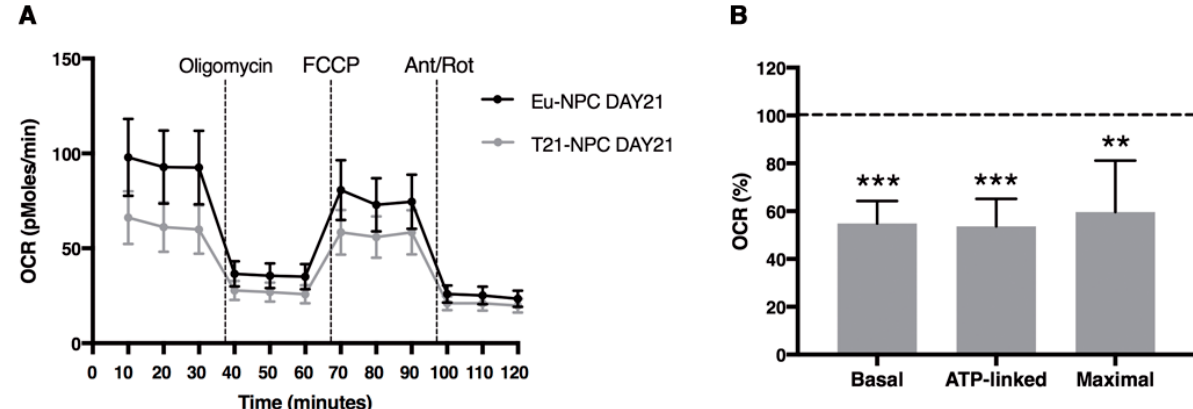
Figure 12. Mitochondrial respiratory function in euploid and trisomic NPCs at day 21 of culture in differentiation medium. ( A ) Merged curves of mean values of OCR obtained in basal condition and after consecutive addition of oligomycin, FCCP and Antimycin-A/Rotenon. ( B ) Relative mean values ± SEM of Basal OCR, ATP-linked and maximal respiration of two T21-NPC clones were expressed as percentage of Eu-NPC values, set equal to 100 (dashed line). Each experiment was carried out at least in triplicate. ** p < 0.01; *** p ≤ 0.001.